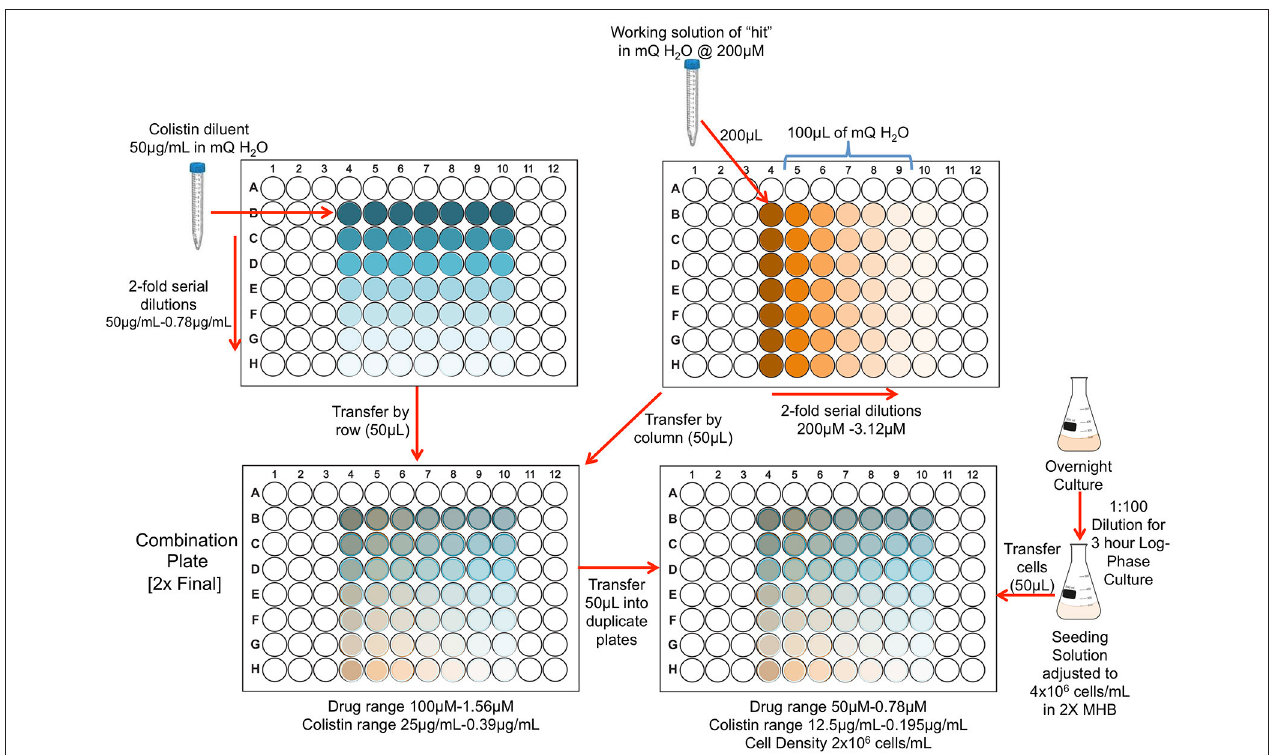
FIGURE 2 | Schematic of checkerboard